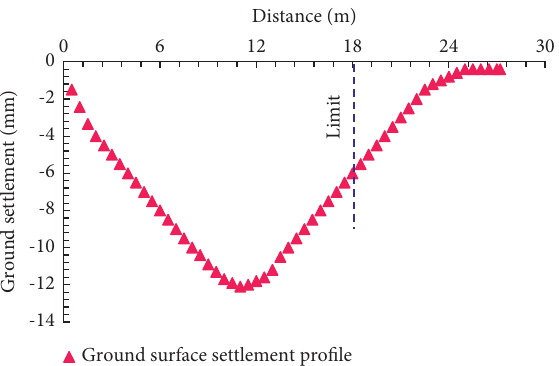
Ground surface settlement profile Figure 8: Influence of the application of steel bracing support alone on the profile of ground surface influence zone